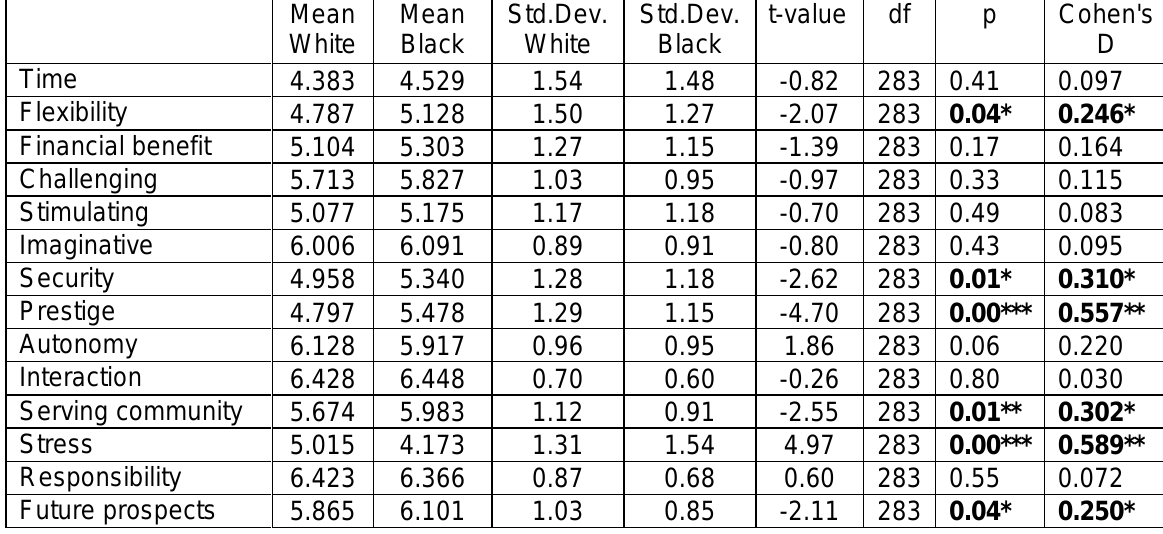
TABLE 5 ETHNICITY OF SMALL BUSINESS OWNERS AND WORK VALUES (WHITE N = 142; BLACK N = 143) Mean White